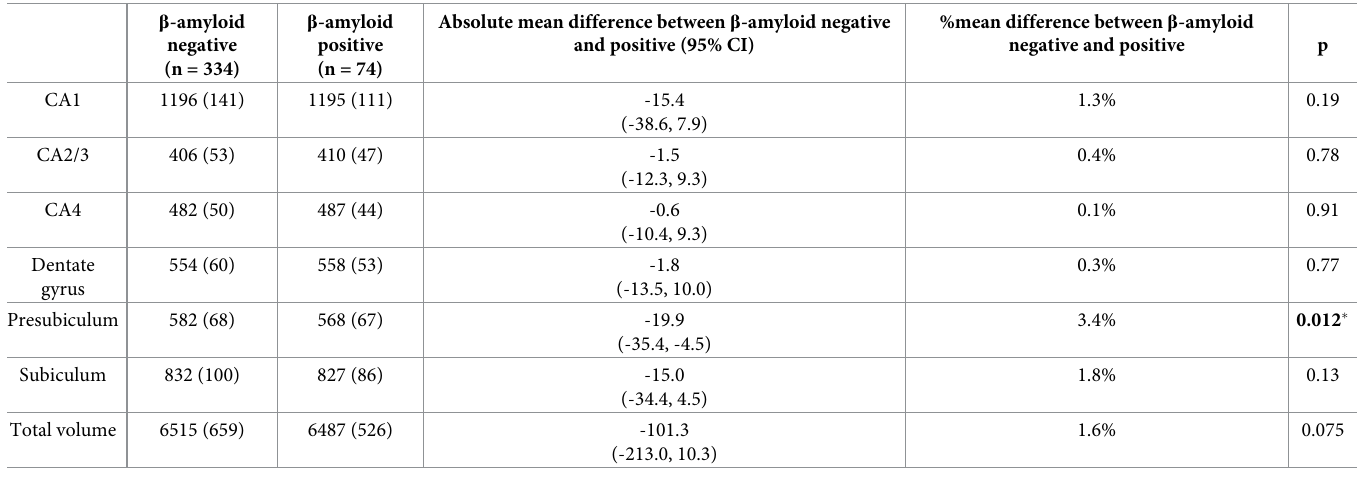
Table 2. Independent influence of amyloid positivity on individual hippocampal subfield volumes in cognitively normal Insight-46 participants (n = 408) using lin- ear regression models with robust standard errors (co- variates = age at scan, WMHV, sex and TIV). β -amyloid negative